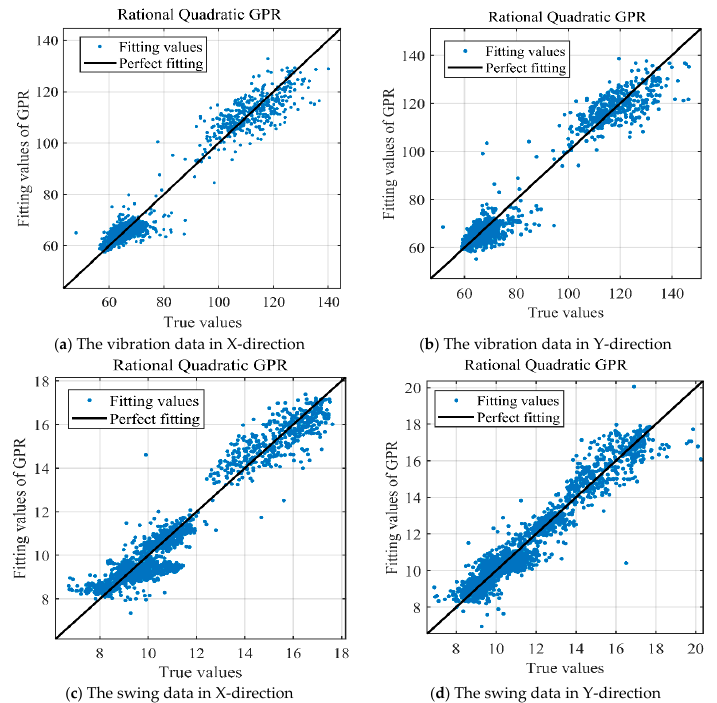
Figure 6. The fitting results of GPR: ( a ) the vibration data in X-direction, ( b ) the vibration data in Y-direction, ( c ) the swing data in X-direction, ( d ) the swing data in Y-direction .